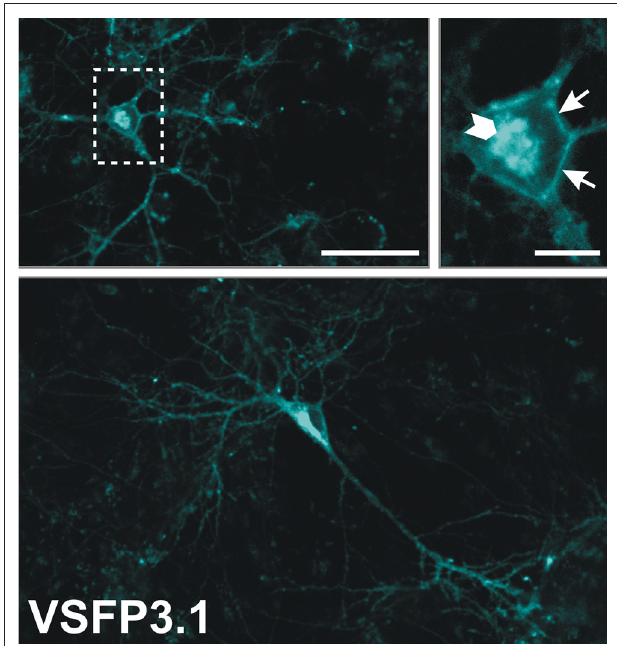
FIGURE 6 | Expression pattern of VSFP3.1 in cultured mouse hippocampal neurons. Primary hippocampal cultures were transfected with VSFP3.1 6 days after plating and confocal images were taken 6 days later. Overviews and magnifi ed views of VSFP3.1 expression in transfected hippocampal neurons are shown. The boxed region in the left panel is shown magnifi ed on the right panel. Arrows indicate plasma membrane expression whereas the arrowhead shows intracellular expression. Scale bar is 50 µm (upper left and lower panel) and 10 µm (upper